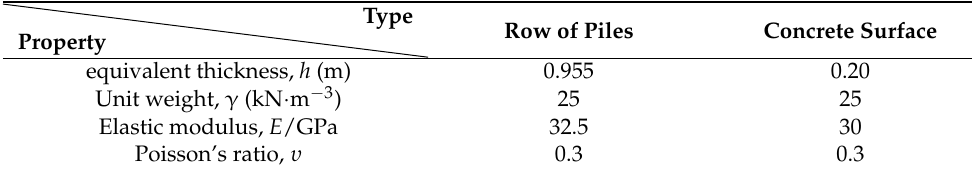
Table 4. Main parameters of bored pile.